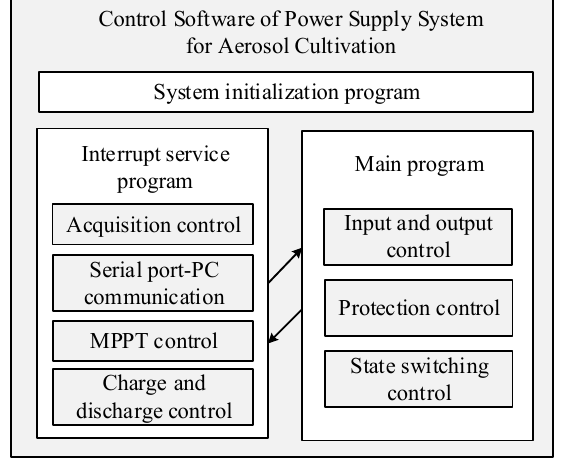
Figure 14. Overall Software Architecture.